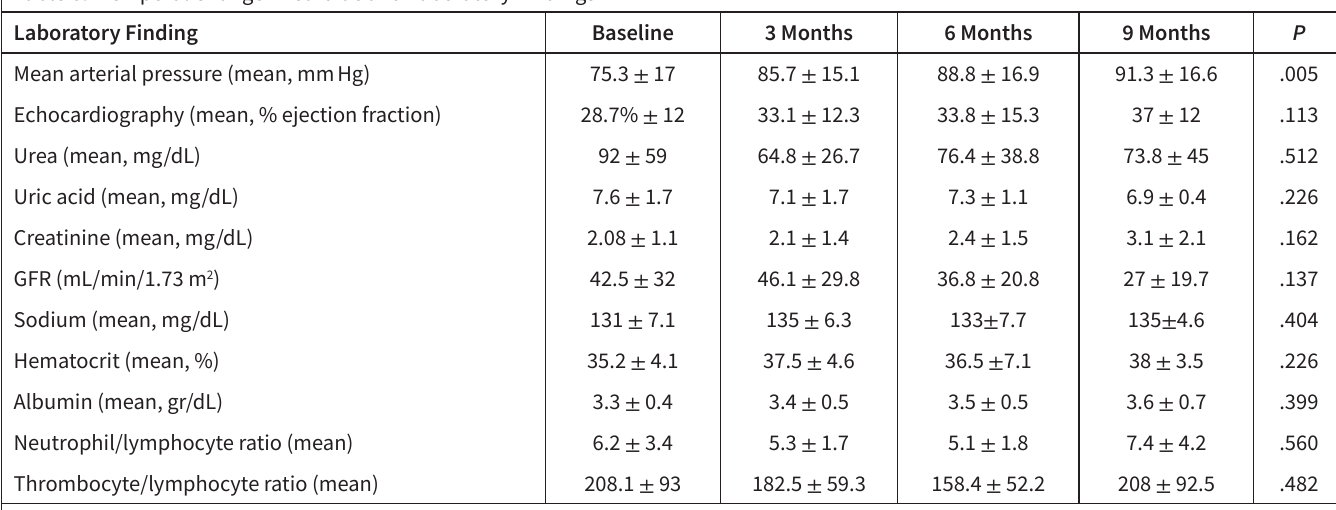
Table 6. Temporal Change in Cardiac and Laboratory Findings Laboratory